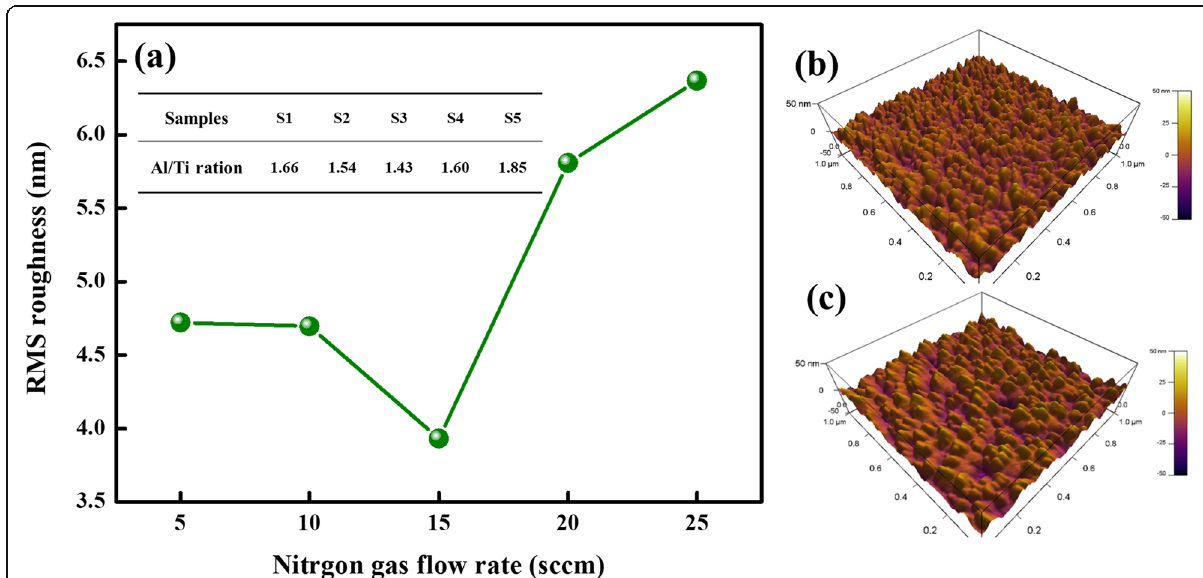
Fig. 4 a RMS roughness values of Ti – Al – N films as a function of nitrogen gas flow rates. Insert table is the values of Al/Ti rations; b and c are the AFM images of S3 and S5 samples, respectively